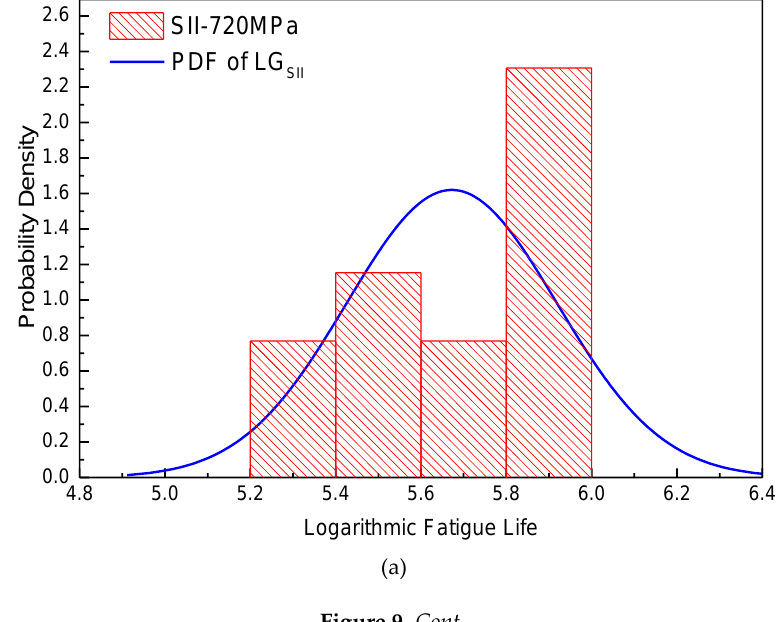
(b) Figure 9. ( a ) FDH of SII under 720 MPa and its PDF; ( b ) FDH of SIS under 800 MPa and its